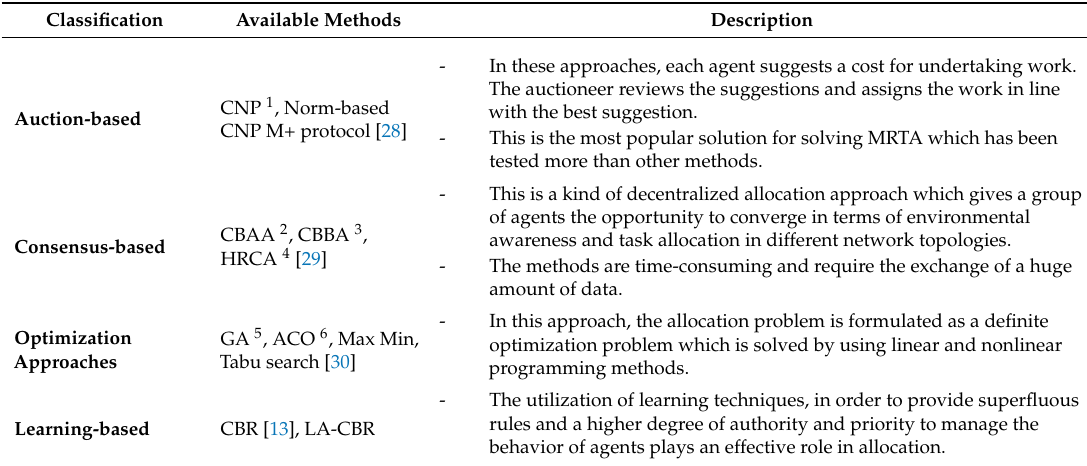
Table 2. A classification of task allocation